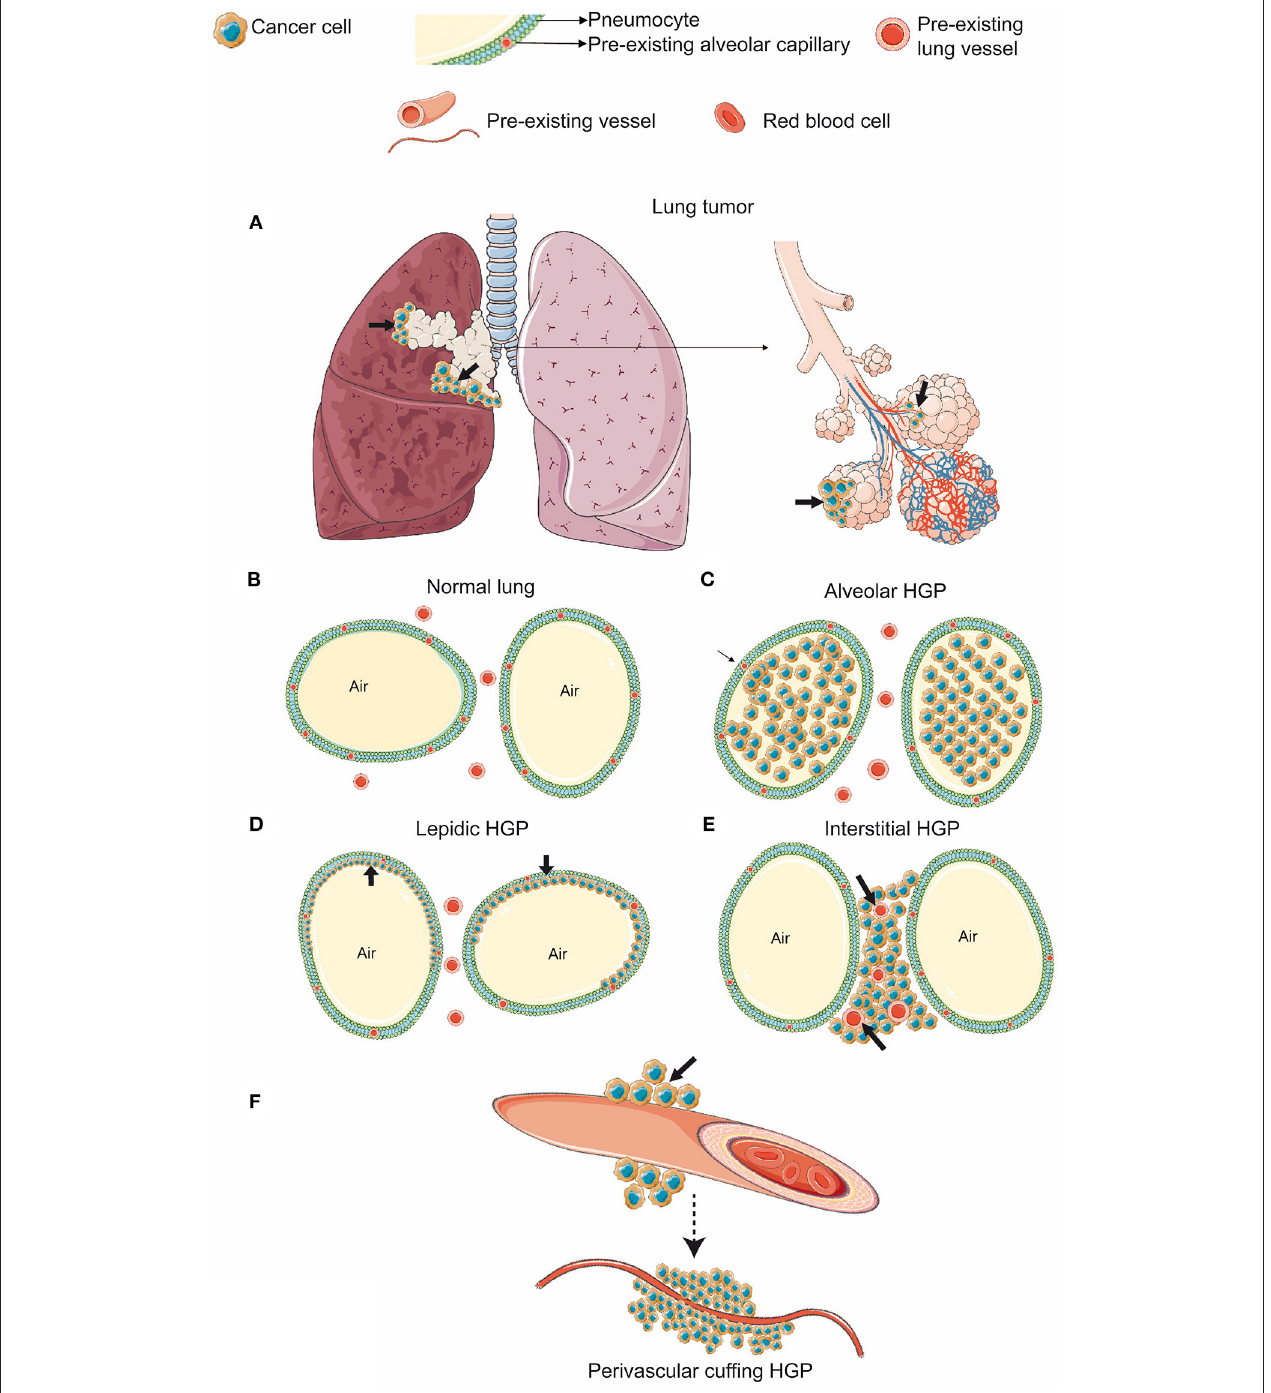
FIGURE 4 | HGP in primary lung cancer (A–F) . (A) Cancer cells growing in the bronchus of the lung (black arrows). (B) In the normal alveolar parenchyma, the lung alveolar spaces are filled by air and are delimited by the alveolar walls. (C) Alveolar HGP. Cancer cells fill the alveolar air space. (D) Lepidic HGP. Cancer cells spread along the alveolar walls, but preserve some air space by not filling the alveoli completely. (E) Interstitial HGP. Cancer cells grow between the alveoli, but do not enter the alveolar space. (F) Perivascular cuffing HGP. Cancer cells grow cuff-like around blood vessels. (Figure created with vectors from Servier Medical Art. https://smart.